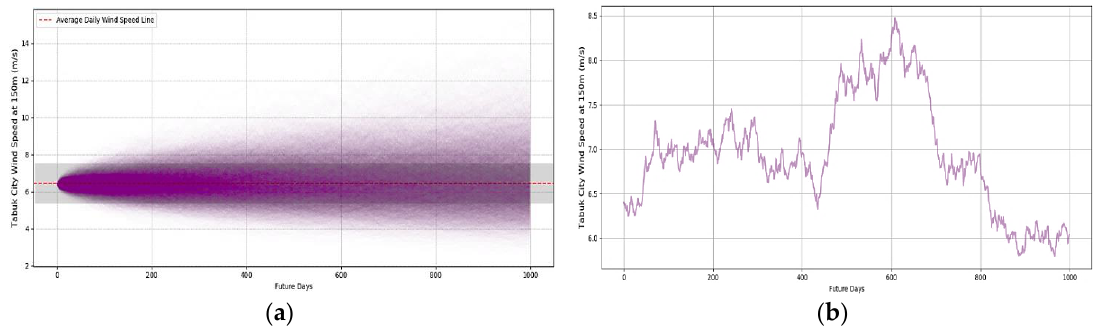
Figure 16. ( a ) Average daily wind speed distributions for the central region, as predicted by MCS and BM, and ( b ) a one-day scenario for the wind speed distribution prediction performance.